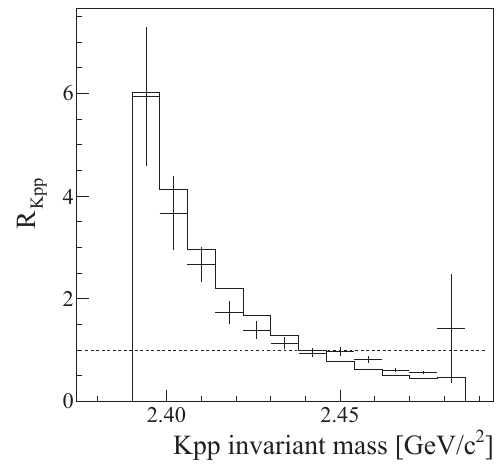
Fig. 2. Ratio of the pp → ppK + K − cross sections in terms of the K − pp invariant mass divided by that using the K + pp mass (cf. [3]). The histogram is the prediction within the FSI model, whereas the dashed line represents the four-body phase-space